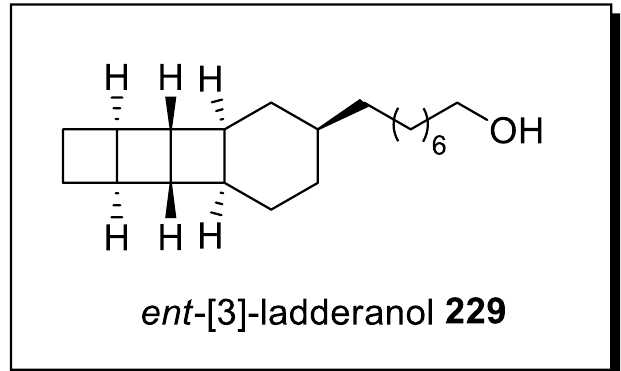
Figure 5. Structure of ent -[3]-ladderanol 229 .